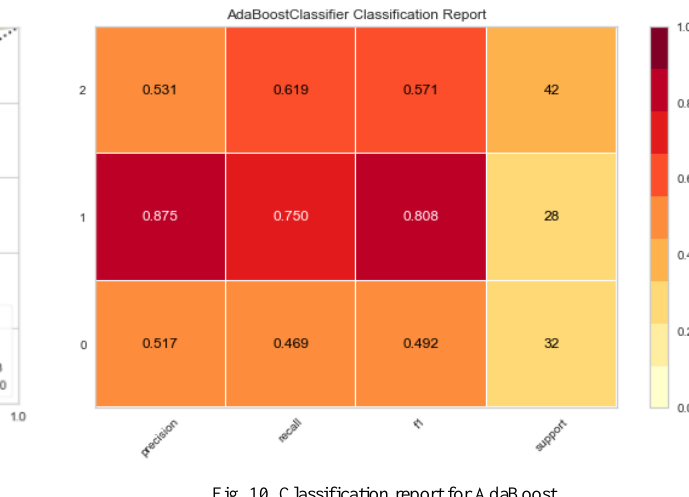
Fig. 10. Classification report for AdaBoost.